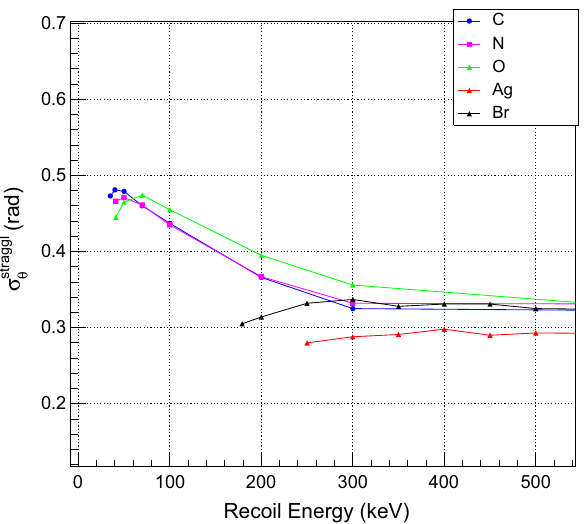
Fig. 2 Angular deviation due to the straggling of nuclei in an emulsion target. A 100 nm threshold on the range of the recoil track is applied